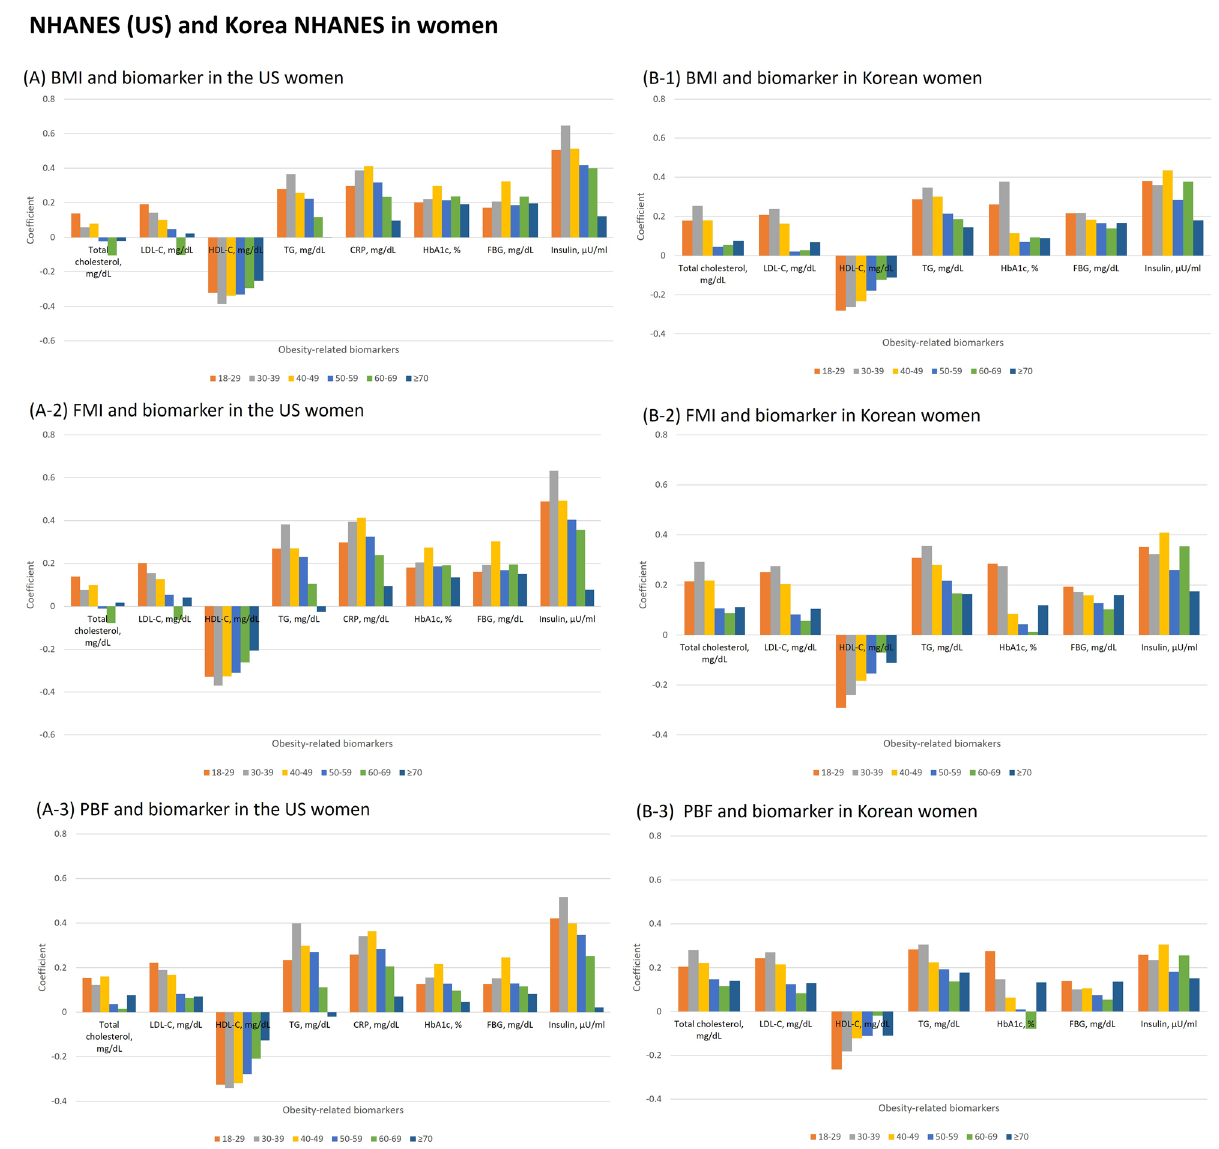
Figure 3. Pearson correlation coefficients between obesity-related biomarkers and body adiposity indices (body mass index, fat mass index and percentage body fat) by age in women. The bar graphs of panel A show coefficients between obesity-related biomarkers (total cholesterol, low-density lipoprotein cholesterol [LDL-C], high-density lipoprotein cholesterol [HDL-C], triglycerides [TG], C-reactive protein [CRP], hemoglobinA1c [HbA1c], fasting blood glucose [FBG] and insulin) and body mass index (BMI), fat mass index (FMI), and percentage body fat (PBF) in National Health and Nutrition Examination Survey (NHANES) and panel B shows the correlations in Korea NHANES. CRP was not available in Korea